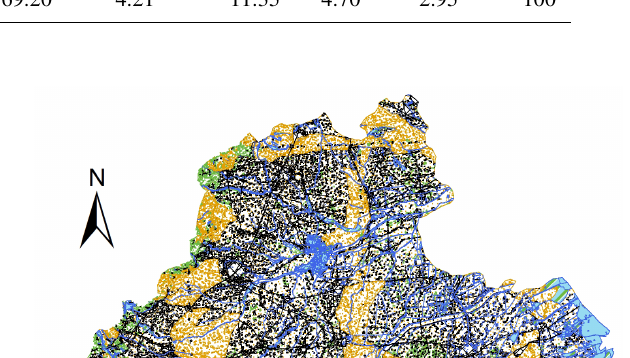
Table 1. Area of each land-use type and their ratios (%). Land use Forestland Shrubland Grassland Cropland Orchard Building Waters Wetland Total Area (10 5 hm 2 ) 3.66 0.31 0.72